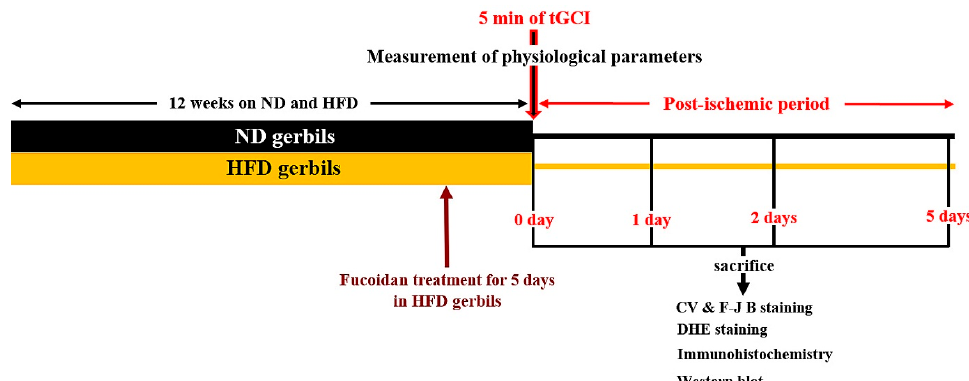
Figure 12. Experimental design. ND or HFD was administered for 12 weeks, and fucoidan was administered to the HFD-fed gerbils for the last 5 days. 12 weeks after the feeding, physiological parameters (body weight, blood glucose levels, and serum lipid concentrations) were measured. After the measurement, the gerbils were subjected to 5 min of tGCI and sacrificed at sham, 1 day, 2 days, and 5 days after tGCI for various